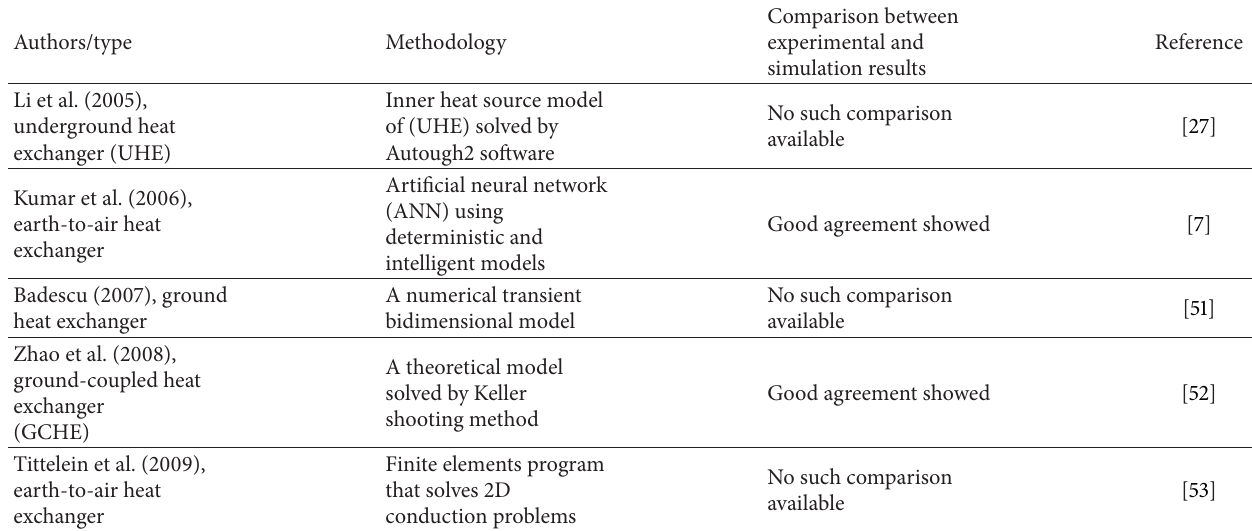
Table 2: Two-dimensional calculation models of EAHE